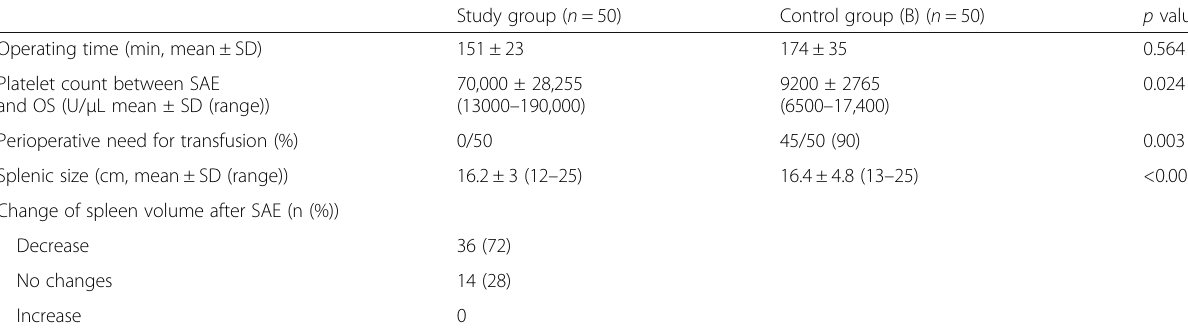
Table 2 Perioperative